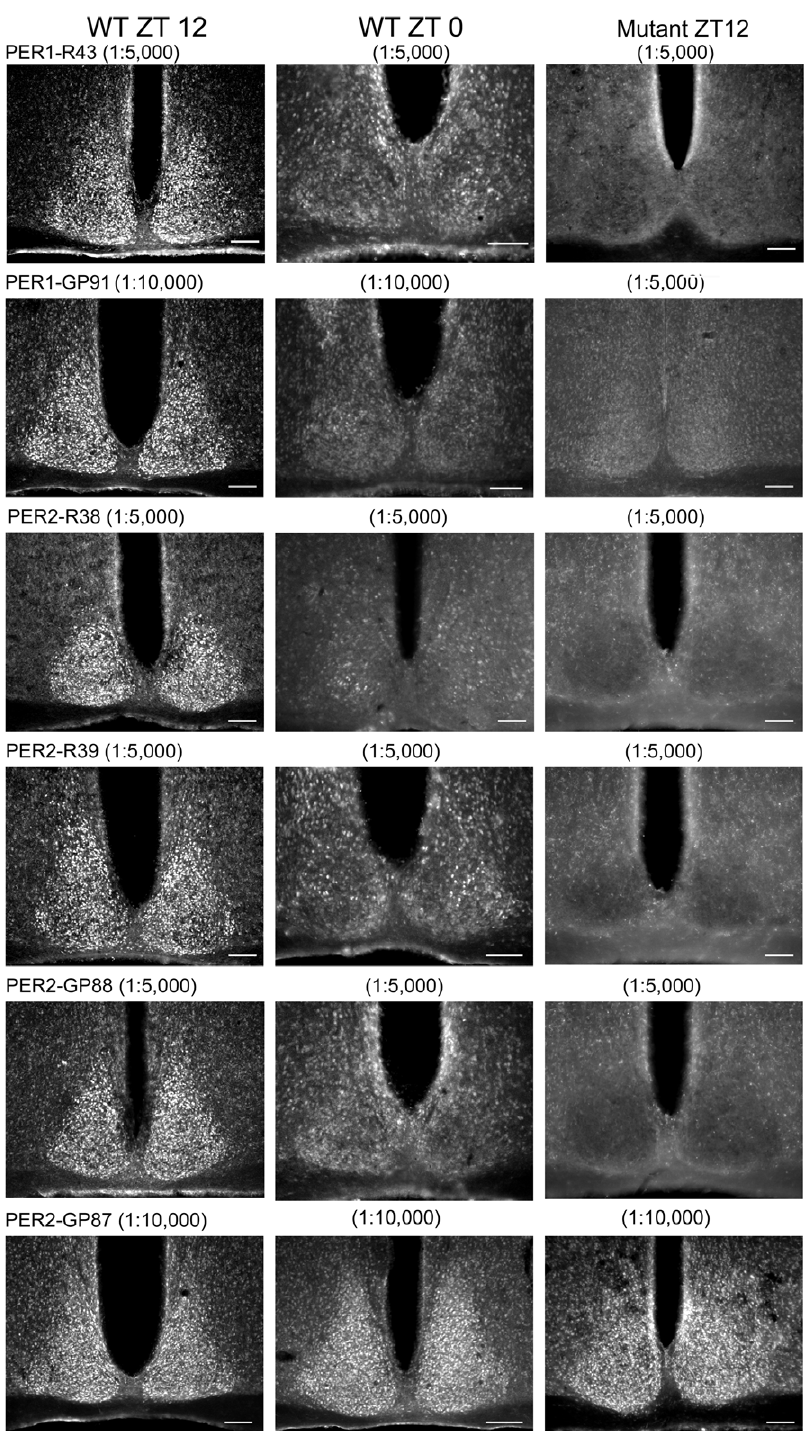
Figure 1. Photomicrographs of mouse SCN sections immunostained with PER1 and PER2 antibodies. The left column shows sections from wild-type mice euthanized at ZT12. The center column shows sections from wild-type mice euthanized at ZT0. The right column shows sections from mice lacking the target antigen (‘‘mutant’’) at ZT12. The antigen, host number (R=rabbit; GP=guinea pig) and antibody concentration used for each antibody is indicated. Scale bar, 100 m m. doi:10.1371/journal.pone.0035938.g001 for R38 and R39. For GP88, concentrations of 1:1,000 gave very Labeling with antibody GP87 was not specific: GP87 gave strong good signal but with higher background; at 1:10,000, SCN cells immunostaining at both ZT12 and ZT0 and staining was present were paler and barely distinguishable from peri-SCN areas. even in the SCN of mPer2 2 / 2 mice (Fig. 1, bottom row).